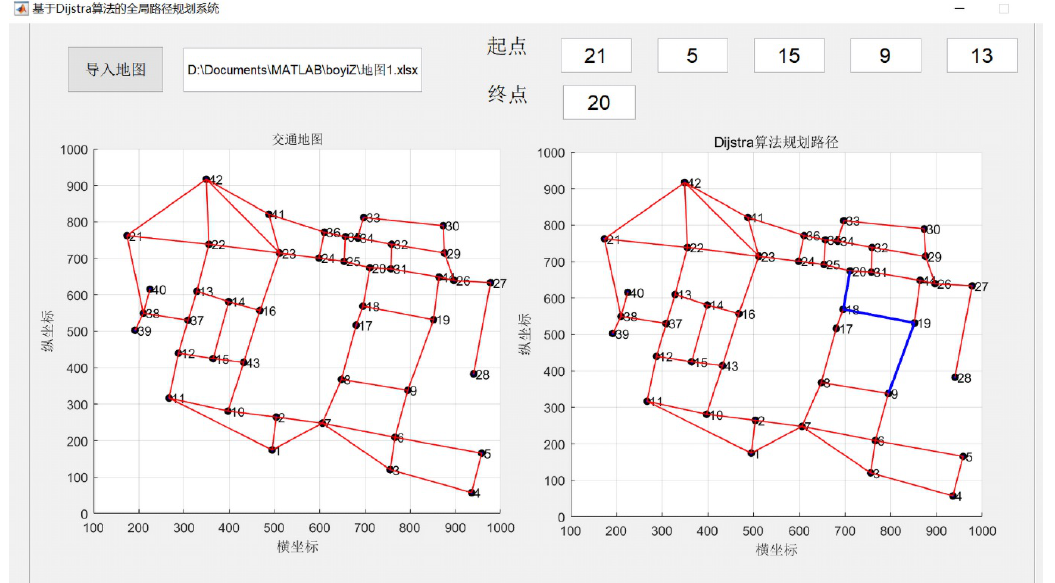
Fig. 7 When m = 5, the shortest path planning is shown as blue